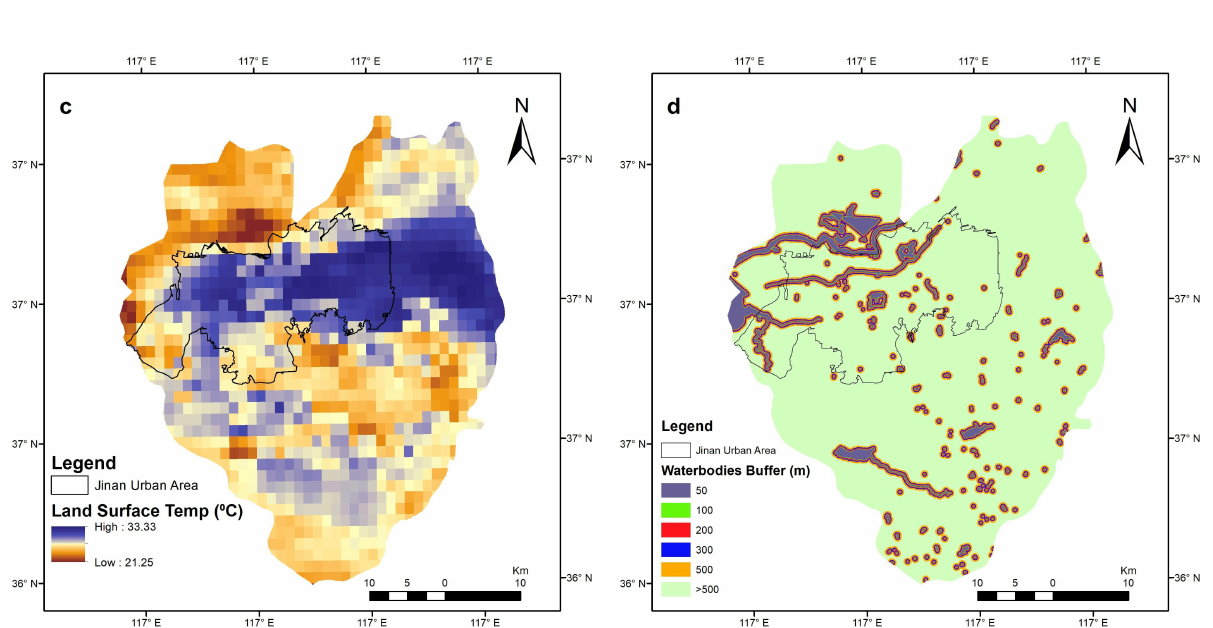
Figure 2. Maps of biophysical factors influencing GI development: ( a ) rainfall, ( b ) air pollution, ( c ) LST, and ( d ) water bodies